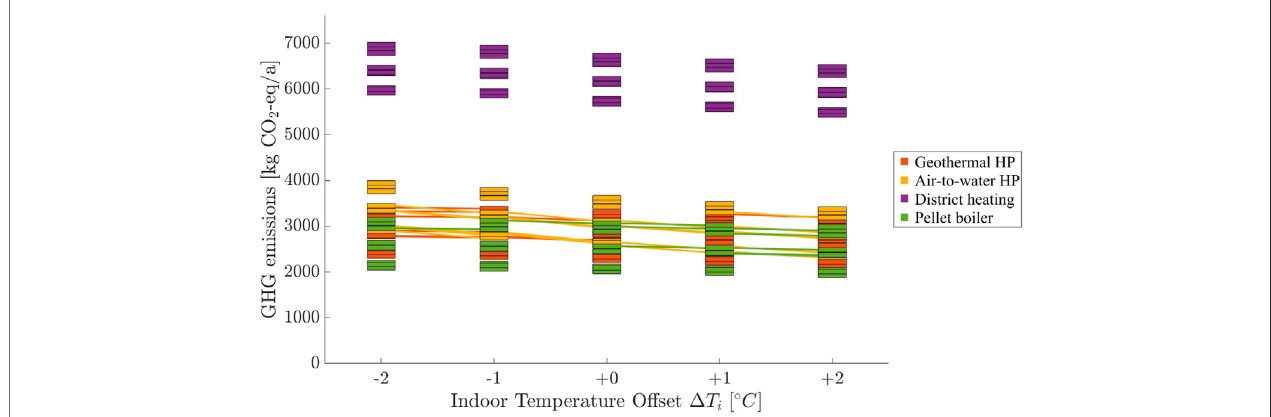
FIGURE5| Measurementuncertaintyimpactonthepredictedperformanceofretro fi tmeasuresinabsolutenumbers,whichshowageneraldownwardstrendfrom left to right and are close in terms of grouping of the most retro fi t measure combinations. Rank changes of retro fi t measure combinations due to measurement uncertainty indicated with lines between the boxes occur rarely.